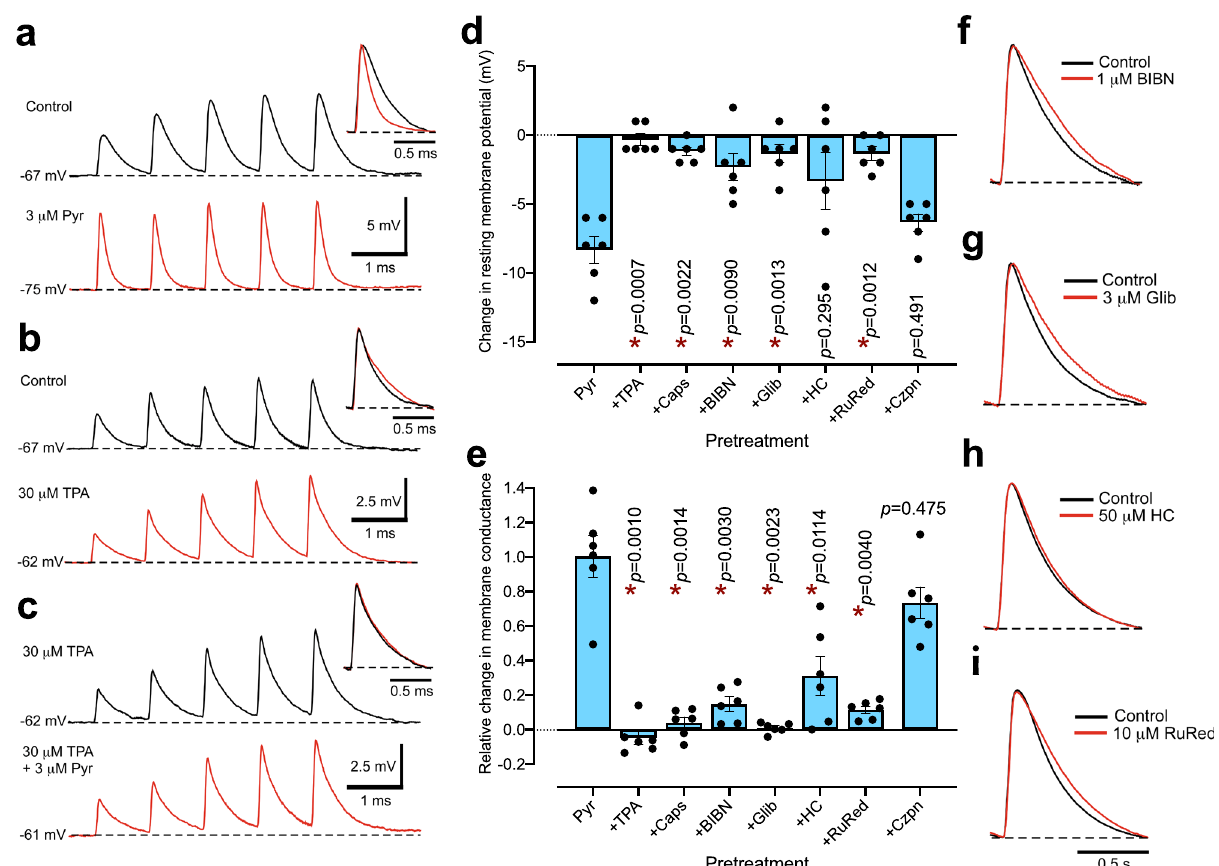
Fig. 3 Zinc modulates vascular smooth muscle conductance and membrane potential via CGRP signaling from rat mesenteric artery sensory nerves. a – c Representative traces of EJPs in individual tissues stimulated with trains of fi ve stimuli at 1 Hz. The zinc ionophore, pyrithione (Pyr, 3 µ M) produced hyperpolarization and accelerated the decay time of EJPs ( a ), whereas the zinc chelator TPA (30 µ M) induced the reverse response ( b ) and neutralized the effects of pyrithione ( c ). Insets are amplitude-normalized, expanded overlaid traces of the 5th EJP with/without treatment. d , e Changes in resting membrane potential ( d ) and membrane conductance (calculated from the 5th EJP; e ) caused by pyrithione alone and with the following pretreatment: TPA (30 µ M, zinc chelation), capsaicin (Caps; 10 µ M; sensory nerve desensitization), BIBN4096 (BIBN; 1 µ M; inhibition of CGRP receptors), glibenclamide (Glib; 3 µ M; blockade of K ATP channels), HC030031 (HC; 50 µ M; inhibition of TRPA1) or ruthenium red (RuRed; 10 µ M; inhibition of TRPA1), and capsazepine (Czpn; 10 µ M; inhibition of TRPV1). Error bars are SEM. *Statistically signi fi cant, Brown – Forsythe – Welch ANOVA [ F (7, 13.93) = 8.659, p = 0.0004 in ( d ) and F (7, 18.36) = 28.63, p < 0.0001 in ( e )] with Dunnett T3 post-test vs. pyrithione. f – i Effects of pretreatment alone on EJP time course. d , e n = 6 arteries from separate